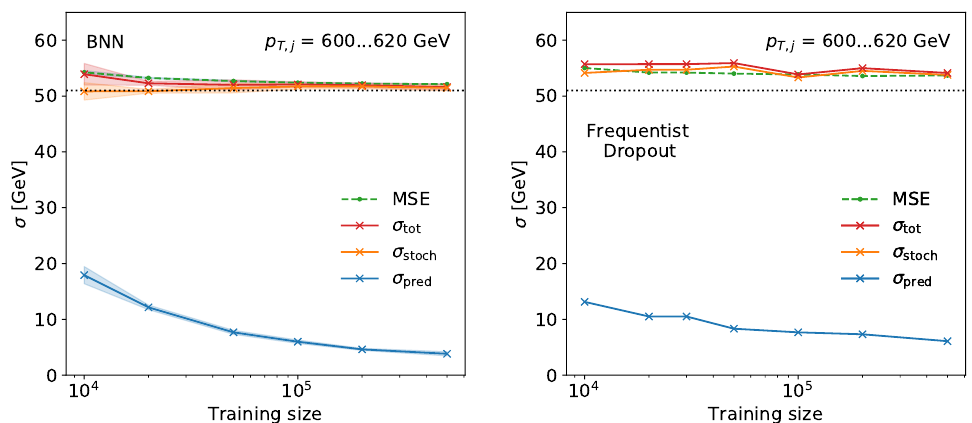
Figure 7: All uncertainties as a function of the training size, comparing the Bayesian network (left) with a (frequentist) set of deterministic networks (right). The left panel corresponds to Fig. 5, and the ranges indicate the standard deviation for five